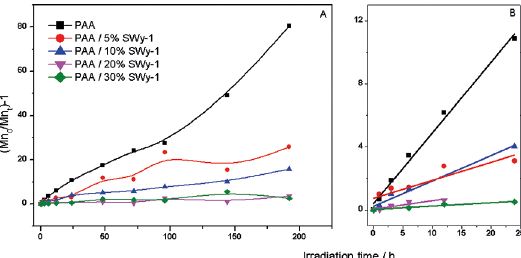
(0)/ M (t)]- 1 as a function of irradiation n n